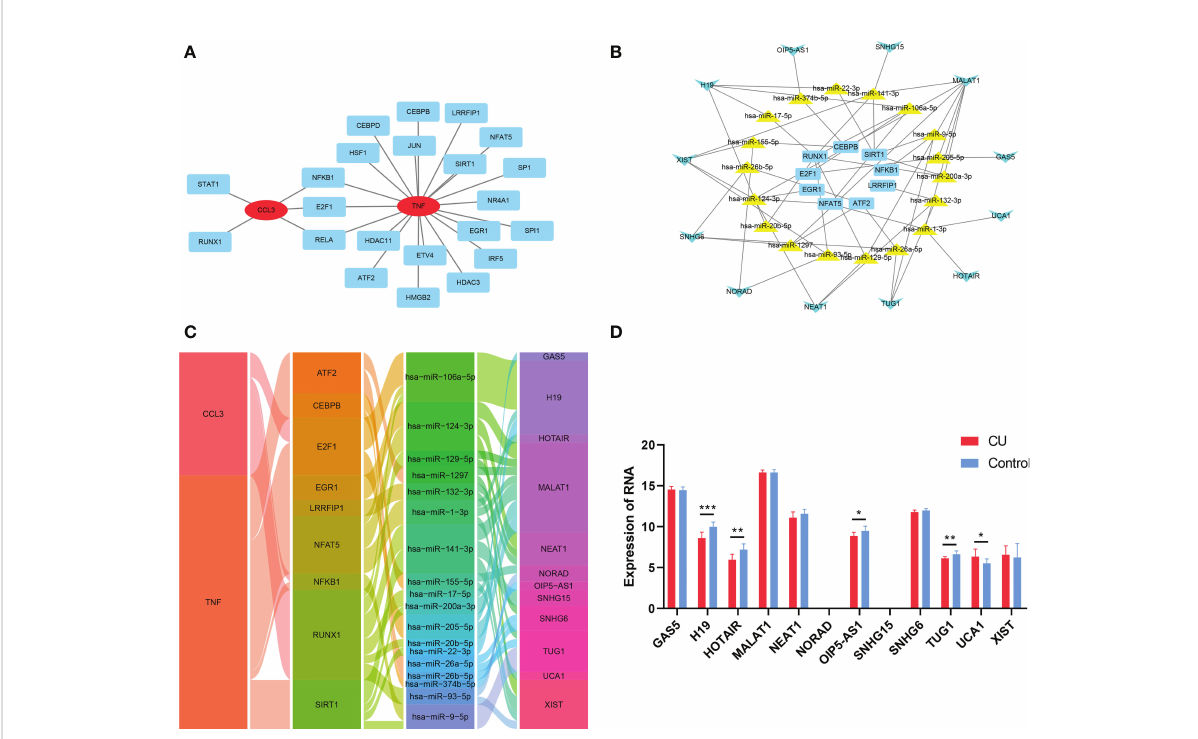
FIGURE 10 Construction of gene-TF- miRNA-lncRNA network of the key genes. (A) The key genes-TFs interaction network. (B) The TF-miRNA-lncRNA ceRNA network. (C) The key gene-TF-miRNA-lncRNA network. (D) The expression of the lncRNAs of the network in CU (GSE57178). *p < 0.05; **p < 0.01; ***p < 0.001.